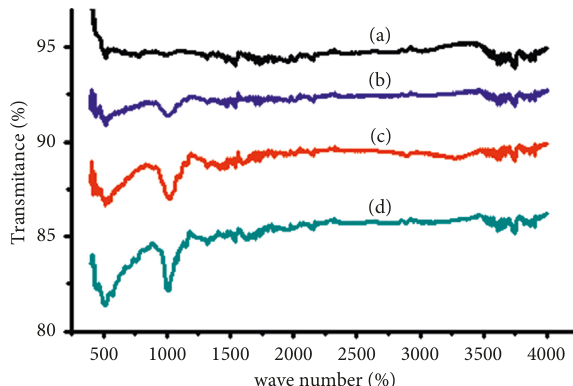
Figure 2: FTIR spectra analysis of (a) raw fiber and (b) (2%), (c) 6%, and (d) 10% NaOH-treated sisal